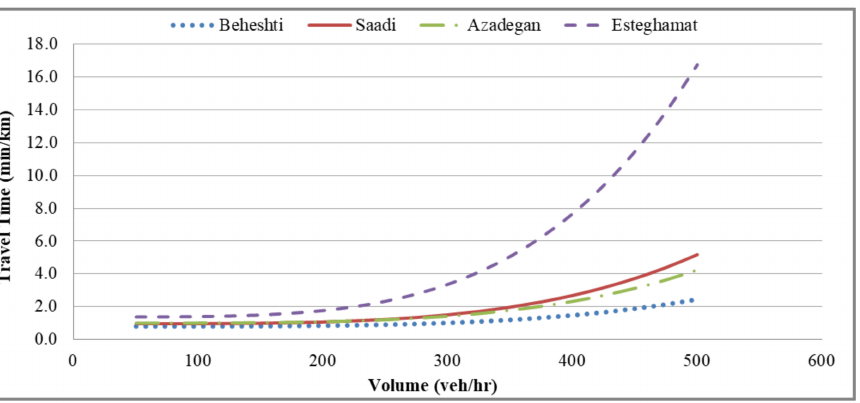
Figure 2. Calibrated Bureau of Public Roads (BPR) functions for the selected roadway